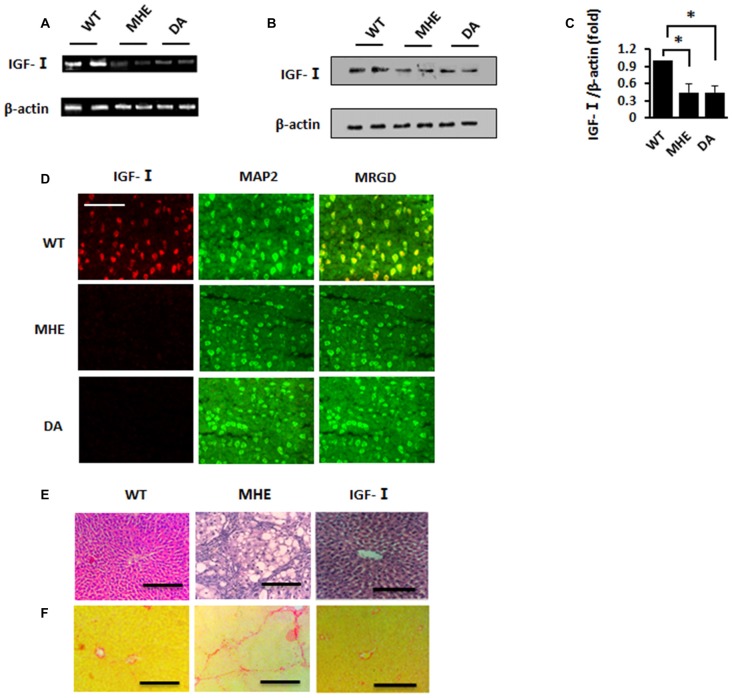
Dopamine (DA) induces downregulation of Insulin-like growth factor I (IGF-I) in minimal hepatic encephalopathy (MHE) and DA-treated rats. (A) Assay for IGF-I mRNAs of hippocampal lysates from MHE rats (n = 13) or DA-treated rats (n = 10) by RT-PCR. (B,C) Immunoblot (IB) analysis of hippocampal lysates from MHE rats or DA-treated rats using anti-IGF-I and anti-β-actin antibodies and subsequent densitometry. (D) Double immunofluorescence (IF) staining of brain sections from MHE rats or DA-treated rats using antibodies against IGF-I (red) and mitogen-activated protein 2 (MAP2; green). (E) H&E staining of liver sections from MHE rats with IGF-I administration. Scale bar, 50 μm. (F) Sirius red staining of liver sections from MHE rats with IGF-I administration. Scale bar, 50 μm. Data are shown as mean ± SD. *P < 0.05. Scale bar, 25 μm. MRGD, merged image.